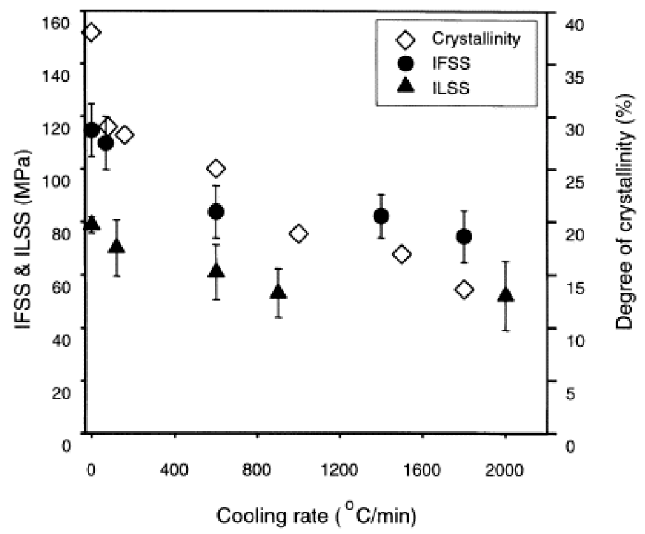
Figure 8. Comparison of IFSS, ILSS, and crystallinity level versus cooling rate